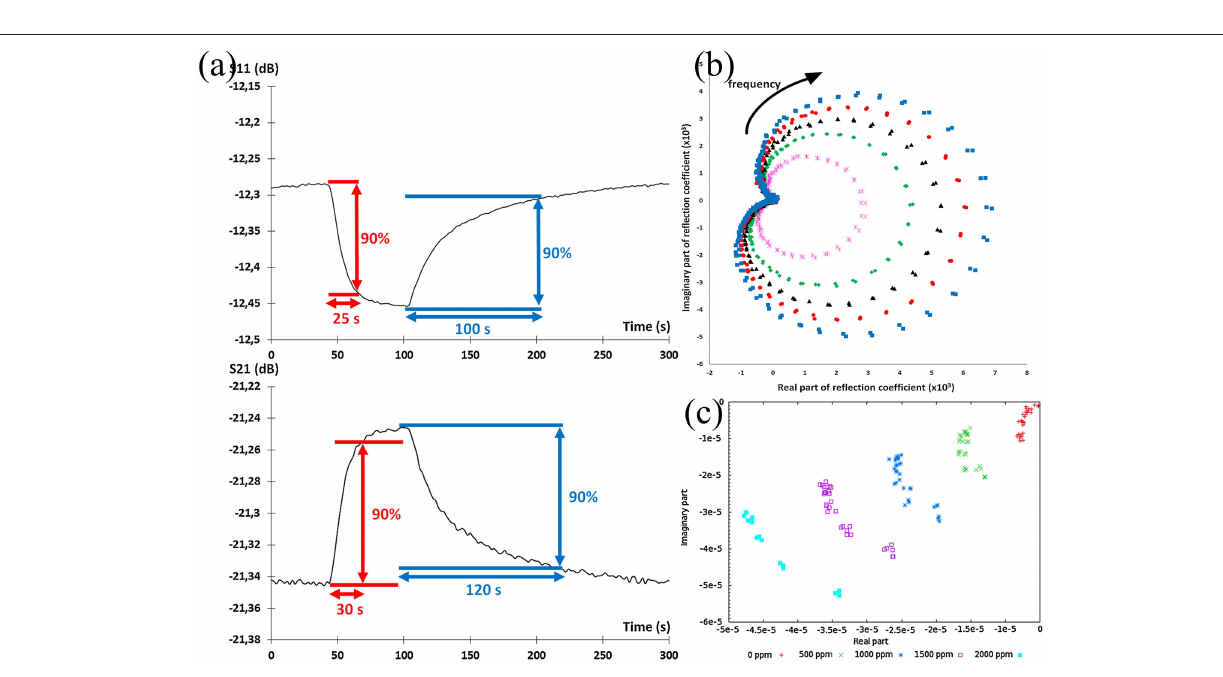
FIGURE 12 | (a) Evolution of S-parameters during the gas sensing, and determination of response and recovery times, (b) imaginary part as a function of real part of S11 for different gas concentrations between 2 and 2.5 GHz, frequency evolution follows the clockwise direction, (c) imaginary part as a function of real part of signal in linear scale at fixed frequency. Reproduced with permissions from Rossignol et al. (2013) and Bailly et al. (2016b). Copyright 2013, 2016